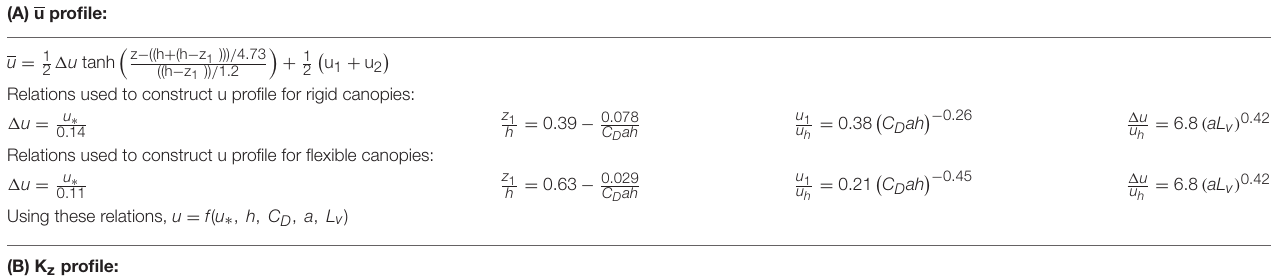
TABLE 1 | Equations describing the curves of (A) mean longitudinal velocity and (B) eddy diffusivity, which require the canopy shear velocity, canopy height, drag coefficient, frontal area, and blade width. (A) u